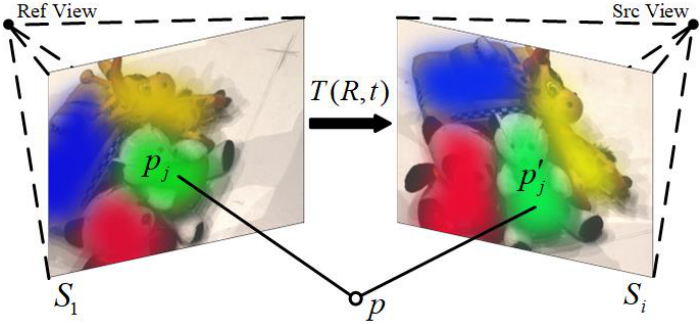
Figure 4. Principle of semantic consistency loss.